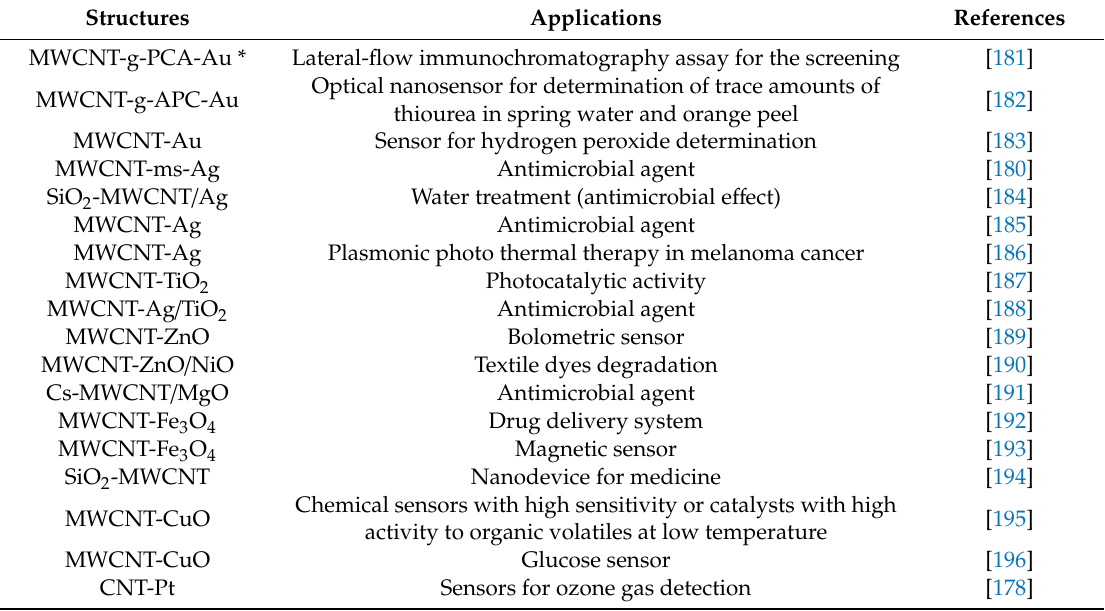
Table 2. Functionalized CNTs and their